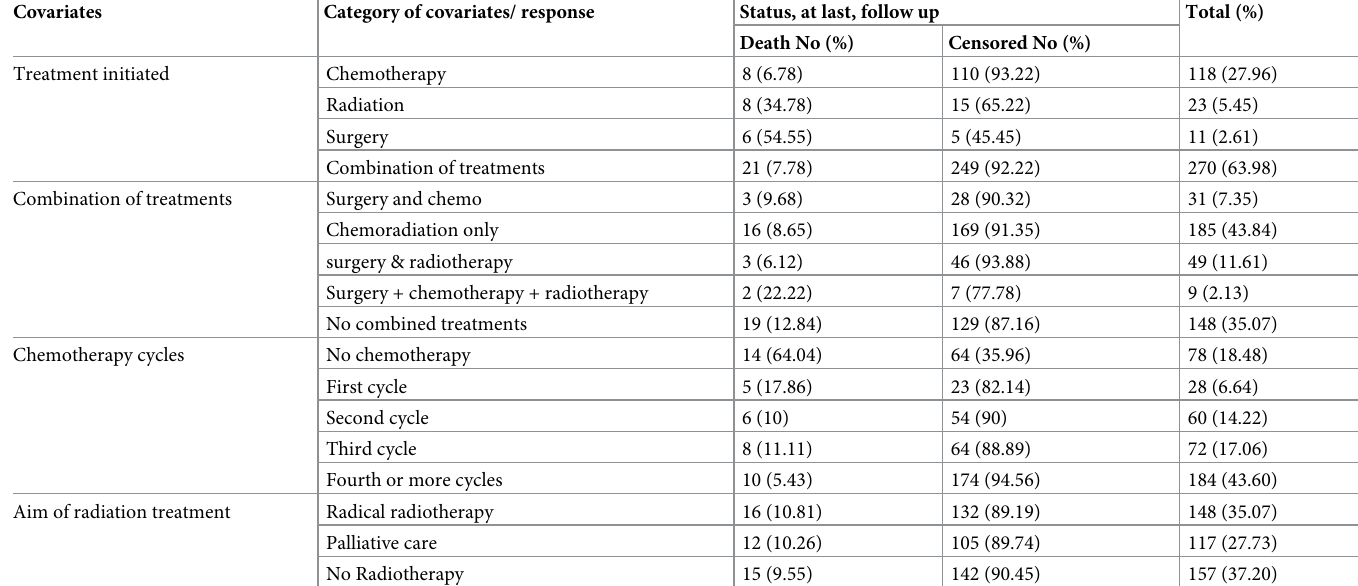
Table 4. Treatment-Related characteristics of cervical cancer patients in Felege Hiwot Comprehensive Specialized Hospital Oncology Center, Ethiopia (n = 422, March 2021).